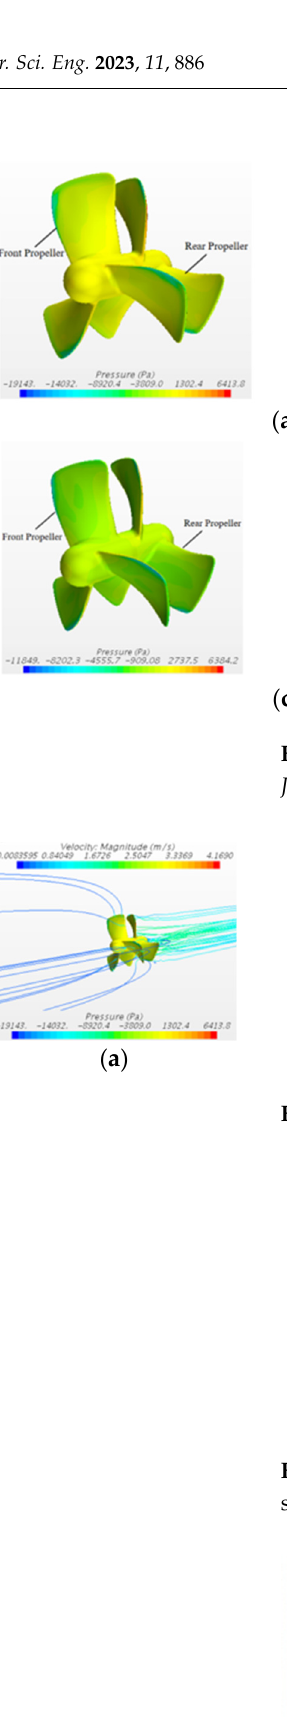
Figure 25. The 3D model ( a ) and the calculation domain ( b ) of the hybrid-driven AUG with the single propeller. Figure 26. Mesh of the hybrid-driven AUG with the single propeller. Figure 26. Mesh of the hybrid-driven AUG with the single Figure 26. Mesh of the hybrid-driven AUG with the single propeller.